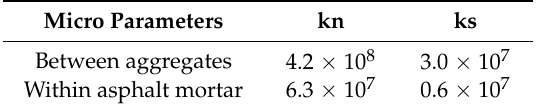
Table 2. Micromechanical parameters of different contacts.